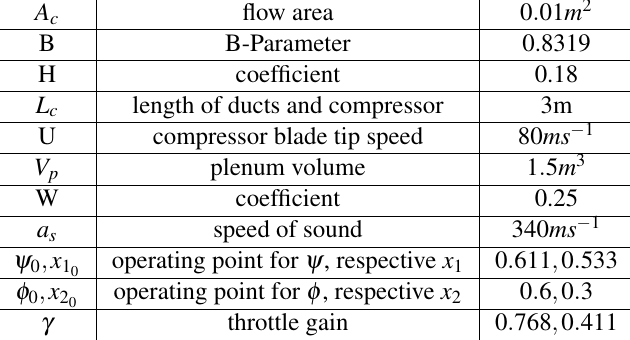
Table 1: Simulation Parameters for the Moore-Greitzer compressor system in combination with a close- coupled valve, adopted from Backi et al.